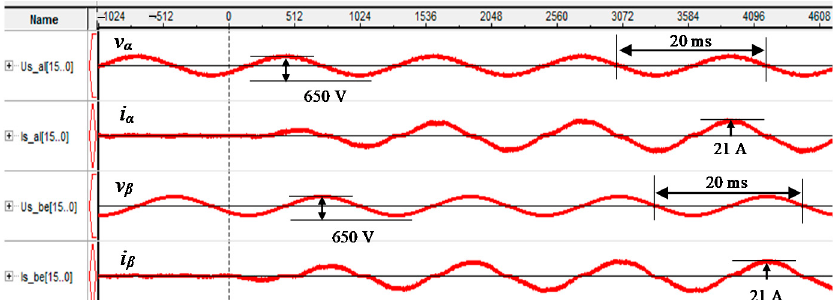
Figure 12. Startup of the device–change in the active component of the current to the nominal P N .